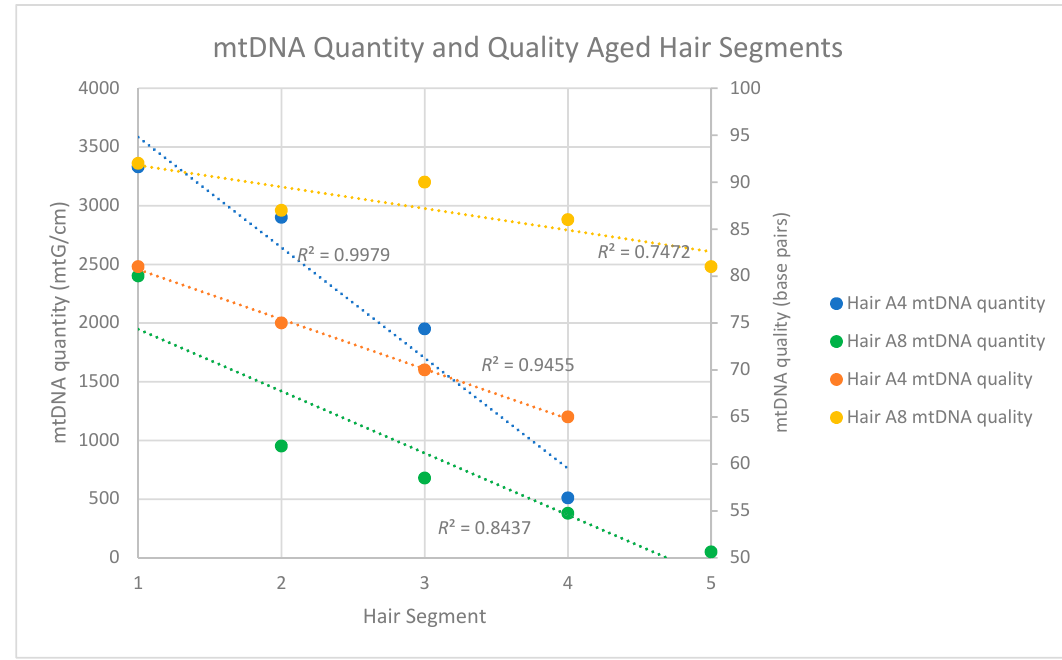
Figure 4. Mitochondrial DNA quality and quantity measures for two single, aged segmented hairs. For hair A4*, the four 5 cm segments spanned 35 cm of hair. For A8, the five 5 cm segments spanned 25 cm of hair. Both came from the same donor.